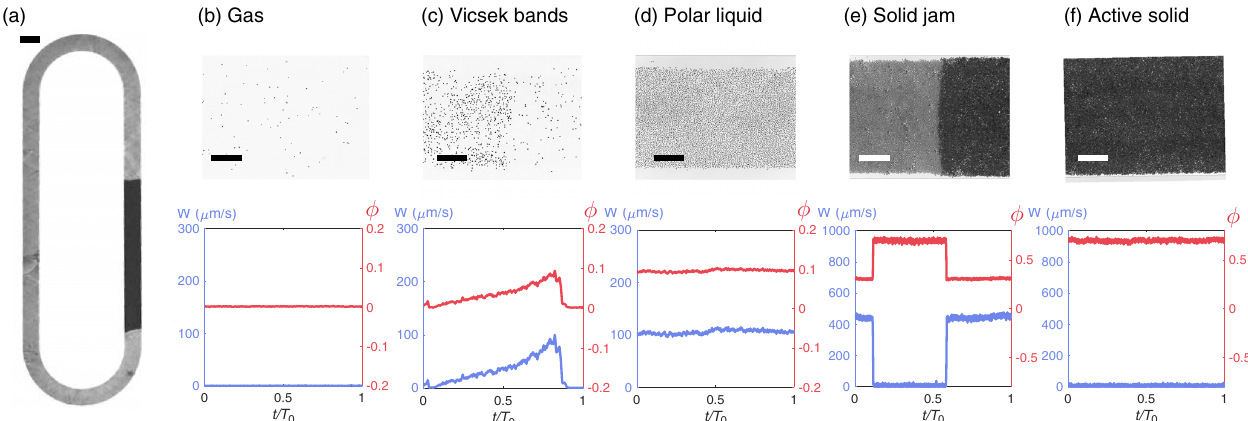
FIG. 1. The dynamical phases of Quincke rollers. (a) Picture of a microfluidic racetrack where ∼ 3 × 10 6 Quincke rollers interact. An active solid (dark gray) propagates through a polar liquid (light gray). Scale bar is 2 mm. (b) – (f) Top: Close-up pictures of Quincke rollers in the racetrack. Scale bars are 250 μ m. Bottom: Longitudinal component of the particle current W and density plotted as a function of a normalized time. Both W and ϕ are averaged over an observation window of size 56 × 1120 μ m 2 . T 0 is arbitrarily chosen to be the time taken by an active solid to circle around the race track. (b) Gas phase ( ϕ 0 ¼ 0 . 002 ). The density is homogeneous and the system does not support any net particle current. (c) Coexistence between an active gas and a denser polar band ( ϕ 0 ¼ 0 . 033 ). A heterogeneous polar-liquid drop propagates at constant speed through a homogeneous isotropic gas in the form of a so-called Vicsek band. (d) Polar-liquid phase ( ϕ 0 ¼ 0 . 096 ). The homogeneous active fluid supports a net flow. (e) Coexistence between a polar liquid and an amorphous active solid ( ϕ 0 ¼ 0 . 49 ). The high-density solid is homogeneous but, unlike the polar liquid, does not support any net particle current. (f) Homogeneous active-solid phase ( ϕ 0 ¼ 0 . 70